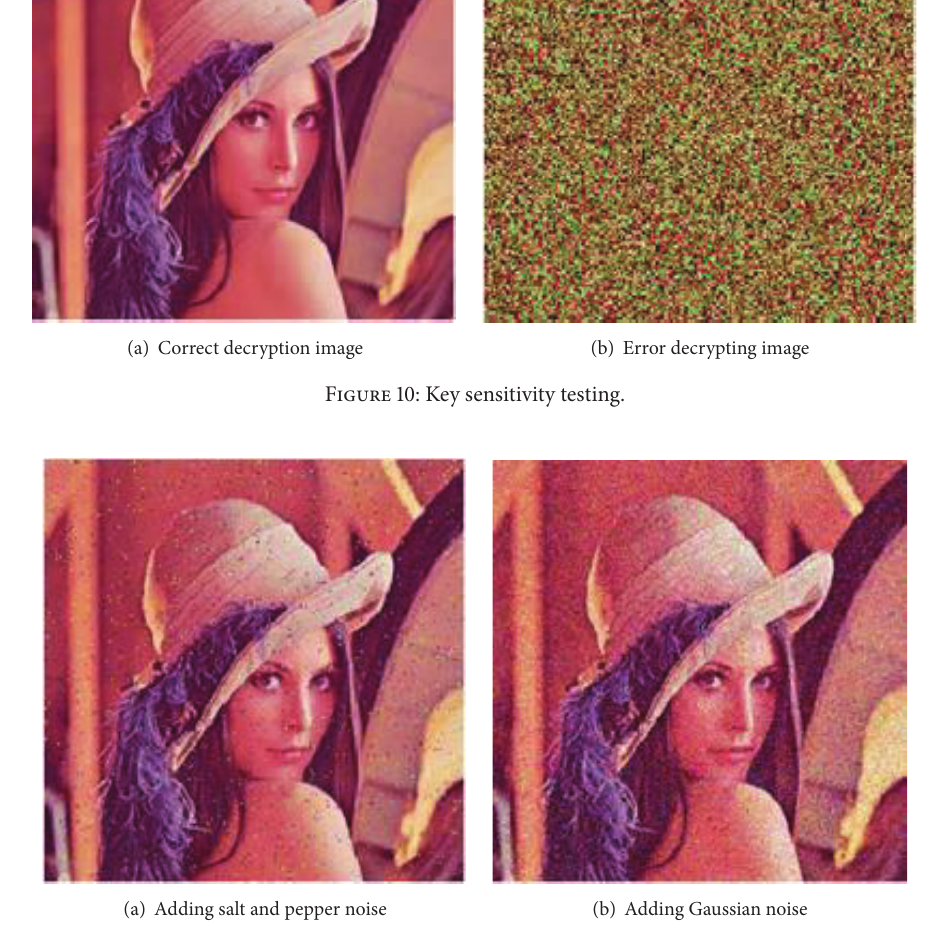
Figure 11: Figure 9(b), the decrypted image, after different noise.